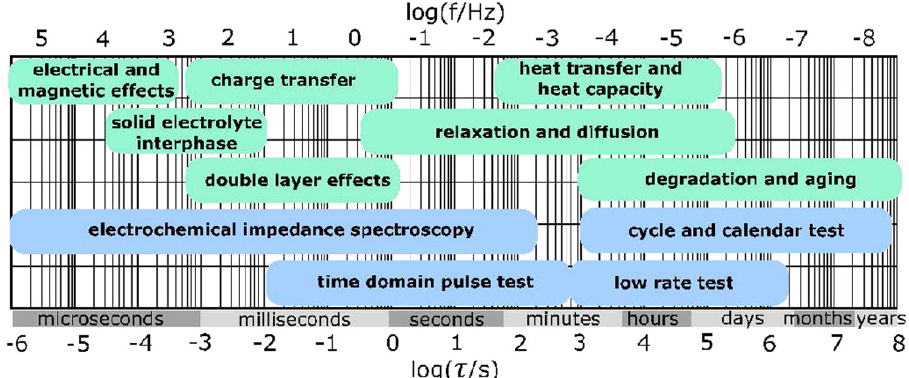
Fig. 7 Dynamic, frequency dependent processes of an electrochemical system (in green) and battery test methods (in blue) with typical ranges of characteristic time constants. This diagram shows the kinetics and their time constants of various electrochemical and physical processes in a battery. The kinds of electrochemical techniques are also recommended for the investigation of the different processes. (reprinted from ref. 24 . open access